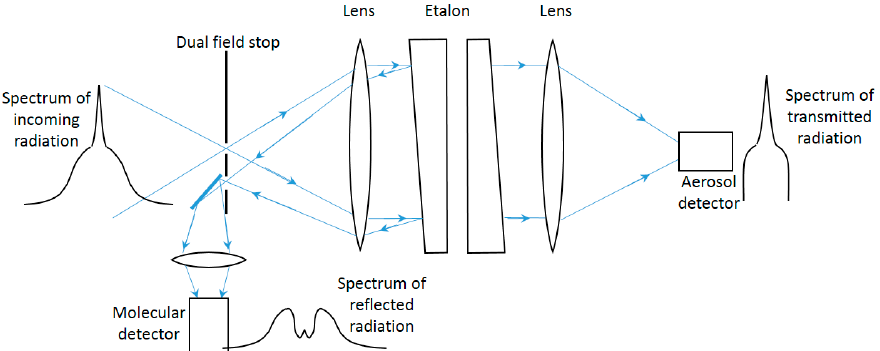
Figure 5. Principle of the HSRL using an etalon to separate the molecular backscatter from the aerosol one (adapted from [62]).